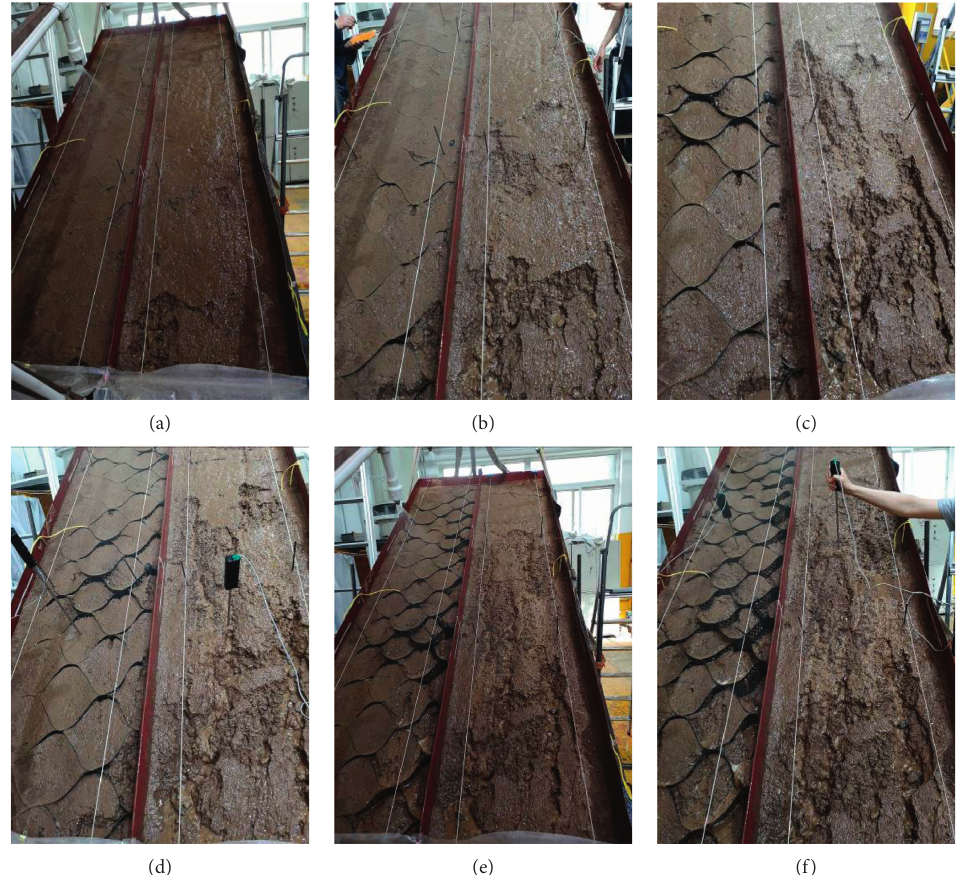
Figure 6: Development of slope erosion during rainfall. Left: geocell-supported slope; right: unsupported slope. (a) 5 min. (b) 7 min. (c) 12 min. (d) 15 min. (e) 20 min. (f) 26